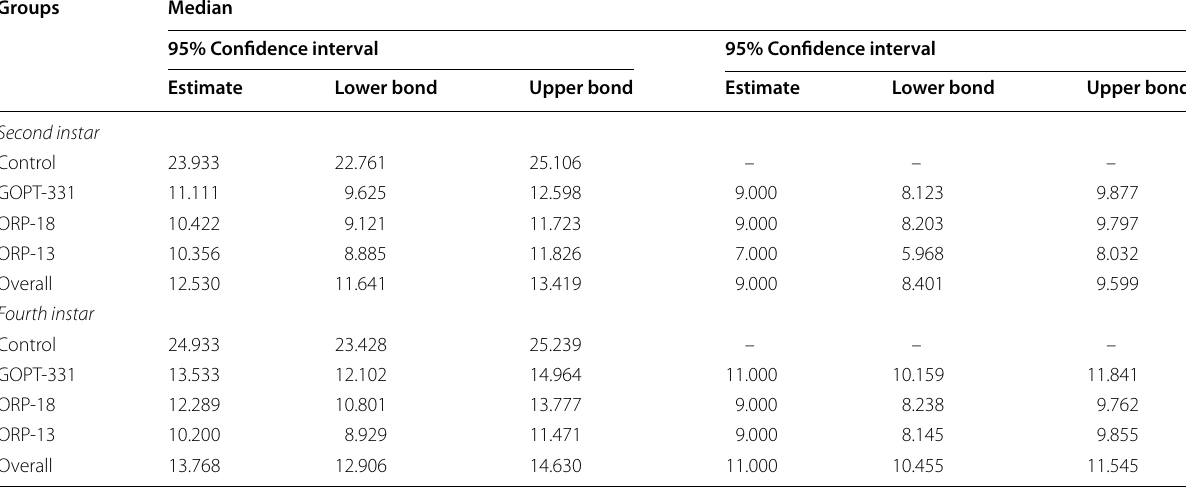
Table 4 Means and medians for survival time results of the second and fourth larval instars of Thaumetopoea wilkinsoni exposed to 1 10 7 and 1 10 8 conidia ml − 1 concentrations for each isolate of GOPT-331, ORP-18, and ORP-13 × × Groups